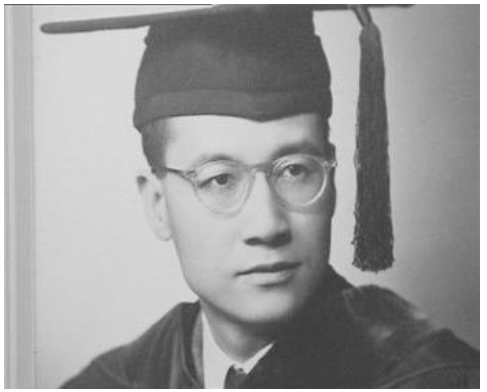
Figure 3. Tu-cheng Yeh (21 February 1916–16 October 2013). Source: courtesy of the Chinese Academy of